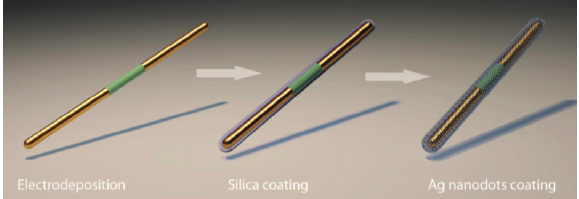
Figure 6. A scheme of the synthesis process of plasmonic magnetic nanocapsules, with permission from